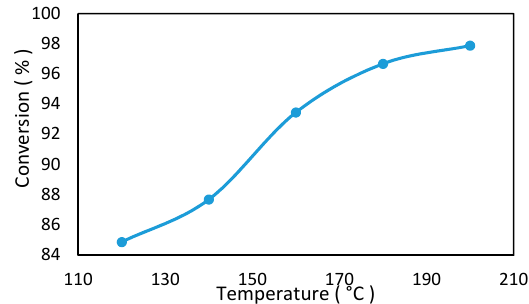
Figure 3. Effect of temperature on biodiesel production (t = 20 min, catalyst = 1.0 mass %, methanol/oil molar ratio = 20:1).